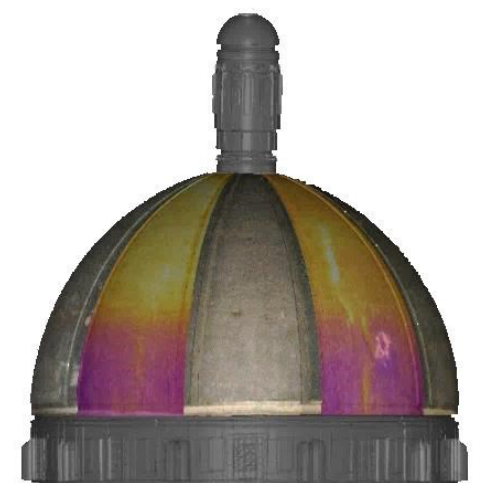
Figure 9. A view of the 3D model textured with the thermal image